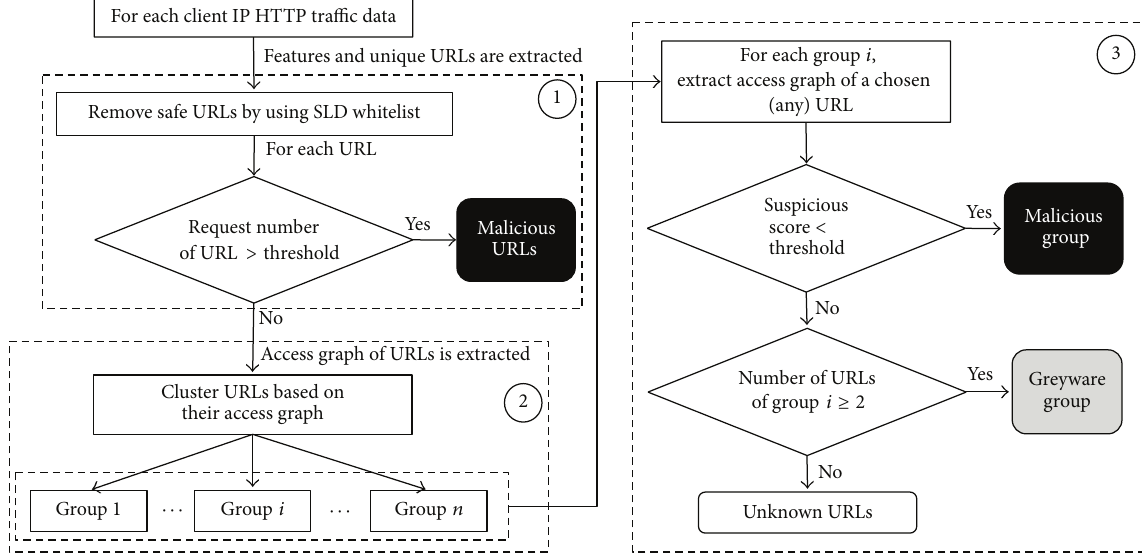
Figure 6: Proposed method diagram in classification and detection of HTTP automated software. Labels of 1, 2, and 3 are preprocesing, clustering, and detection/classification phase, respectively.